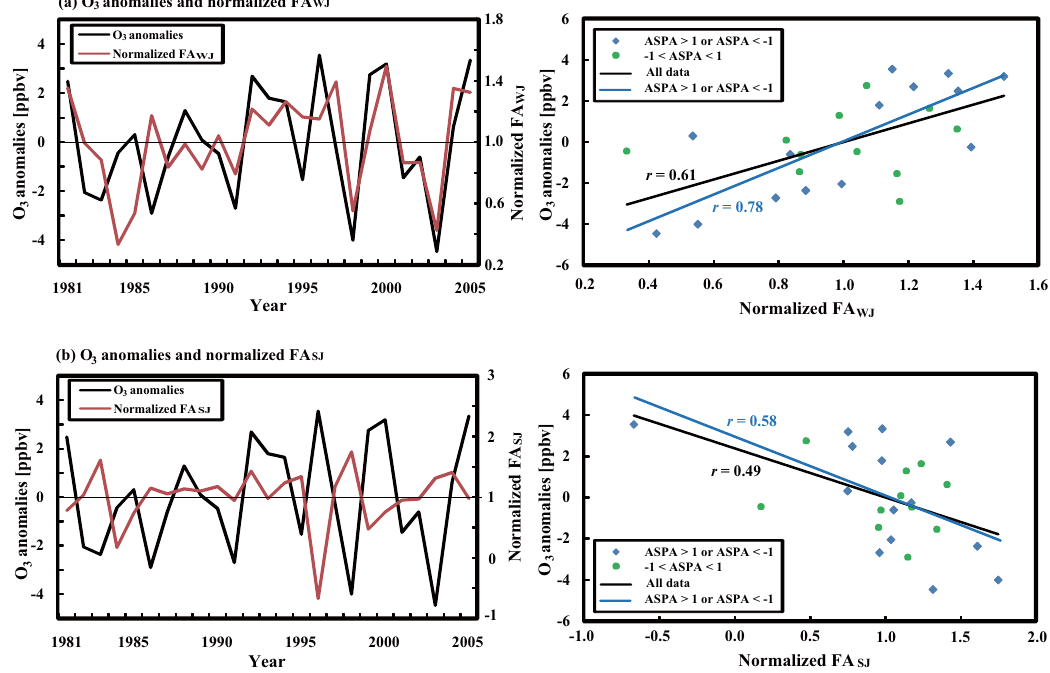
Fig. 8. (a) Time series (left) and scatter plot (right) of O 3 anomalies over WCJ and O 3 flux anomalies across the section along L WJ (FA WJ ) in the springtime BL between 1981 and 2005. (b) The same as in (a) but with O 3 flux anomalies across the section along L SJ (FA SJ ) . See Fig. 1 for the definition of L WJ and L SJ . Values of FA WJ and FA SJ are normalized relative to the respective 25-year average. The colors of points and lines are the same as in Fig. 7. The simulation scenario and the definition of anomalies are the same as in Fig. 6.